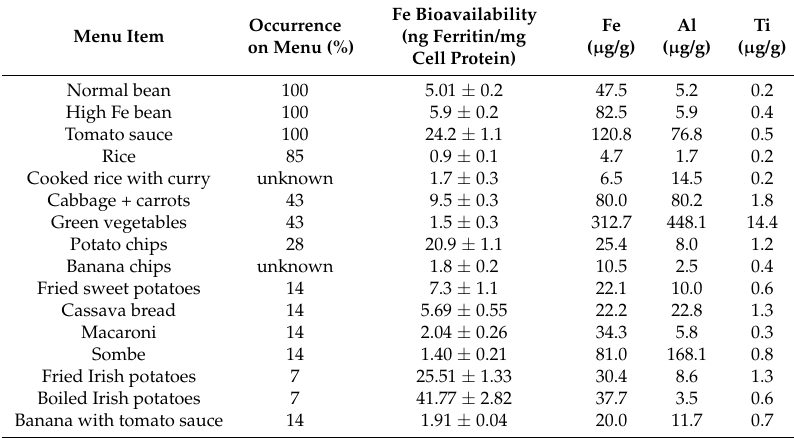
Table 4. Experiment 1. In vitro Fe bioavailability, and mineral (Fe, Al, Ti) content of menu items from human efficacy trial of normal and high Fe beans [8] 1